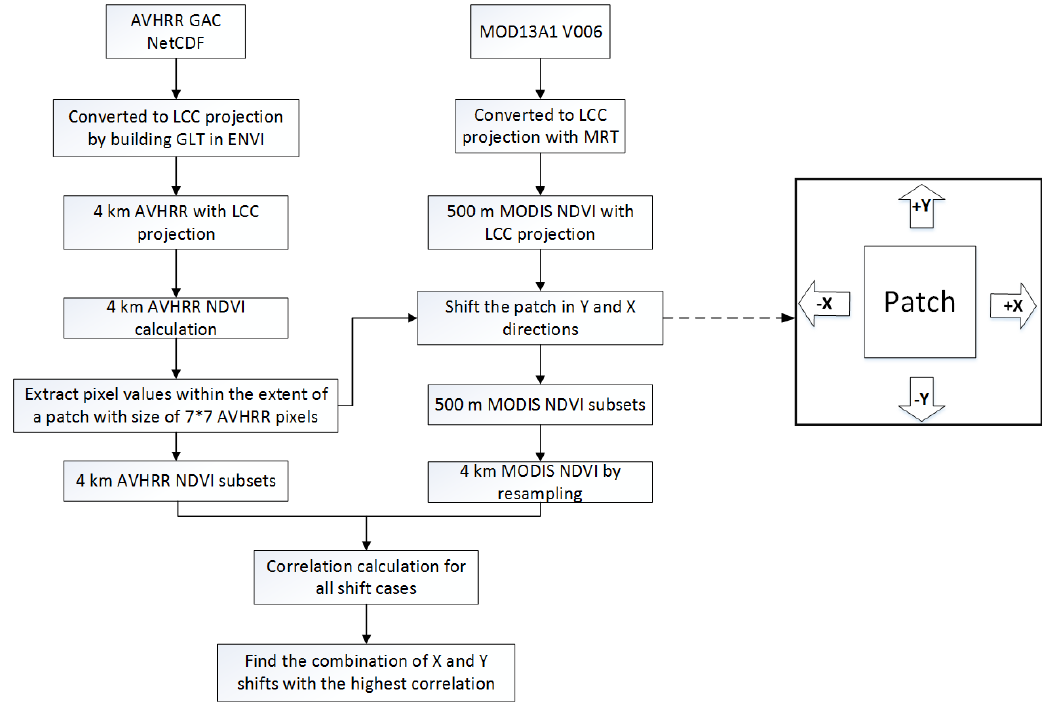
Figure 3. Flowchart of the correlation-based patch matching method